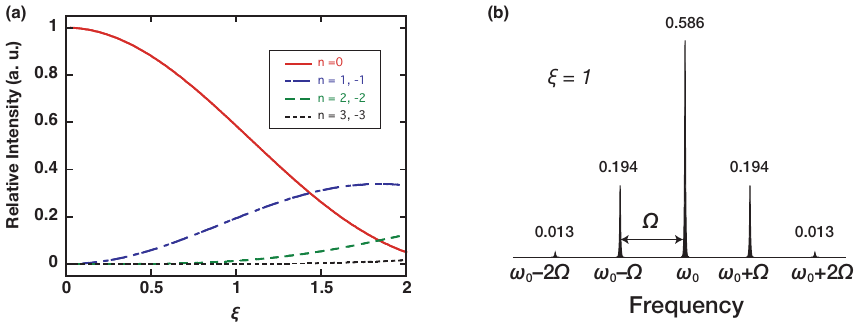
Figure 2. ( a ) Dependence of intensities of the pump beam ( n = 0) and the n-th-order sidebands ( n = ± 1, ± 2, ± 3) on ξ . ( b ) Spectrum for ξ = 1 when the pump beam frequency was ω 0 and the modulation frequency was Ω